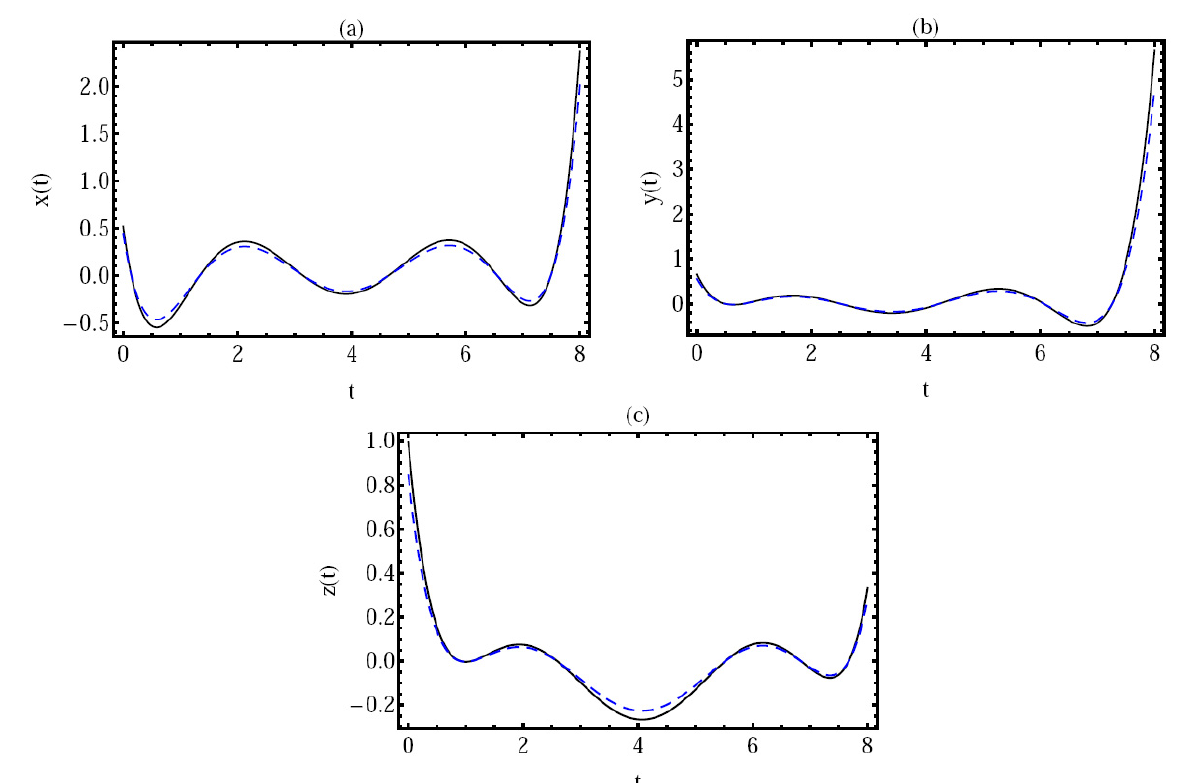
Figure 1. Behavior of the approximate solution by the proposed method (dots line) and the RK4 (continuous